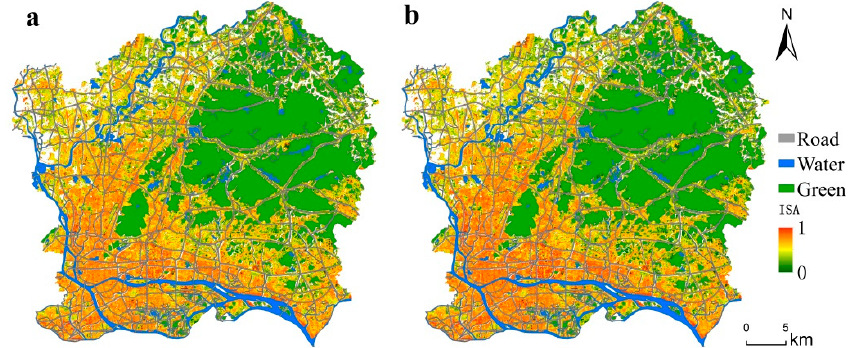
Figure 8. Impervious surface spatial distribution before and after optimization: ( a ) impervious surface spatial distribution before optimization and ( b ) impervious surface spatial distribution after optimization.